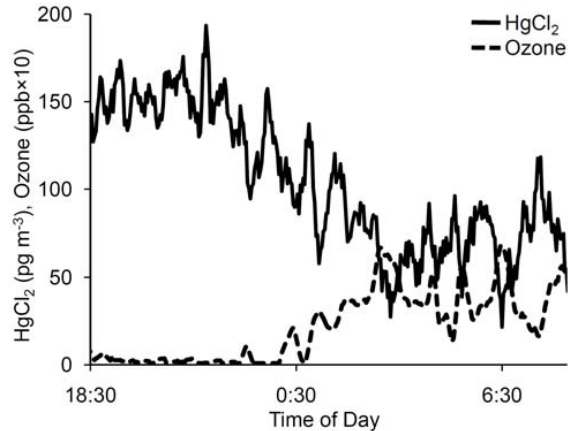
Figure 3. Moving average (of five 2.5 min measurements) of HgCl 2 concentration (measured as the difference between TGM and GEM) and ozone concentration. HgCl 2 was added at a constant rate to particulate-filtered ambient air in a setup similar to that shown in Figure 1, but the measured HgCl 2 concentration decreased as ambient ozone increased. Note that the 2.5 min detection limit for HgCl 2 concentration was 76 pg m -3 , while the 30 min detection limit was ~30 pg m -3 .